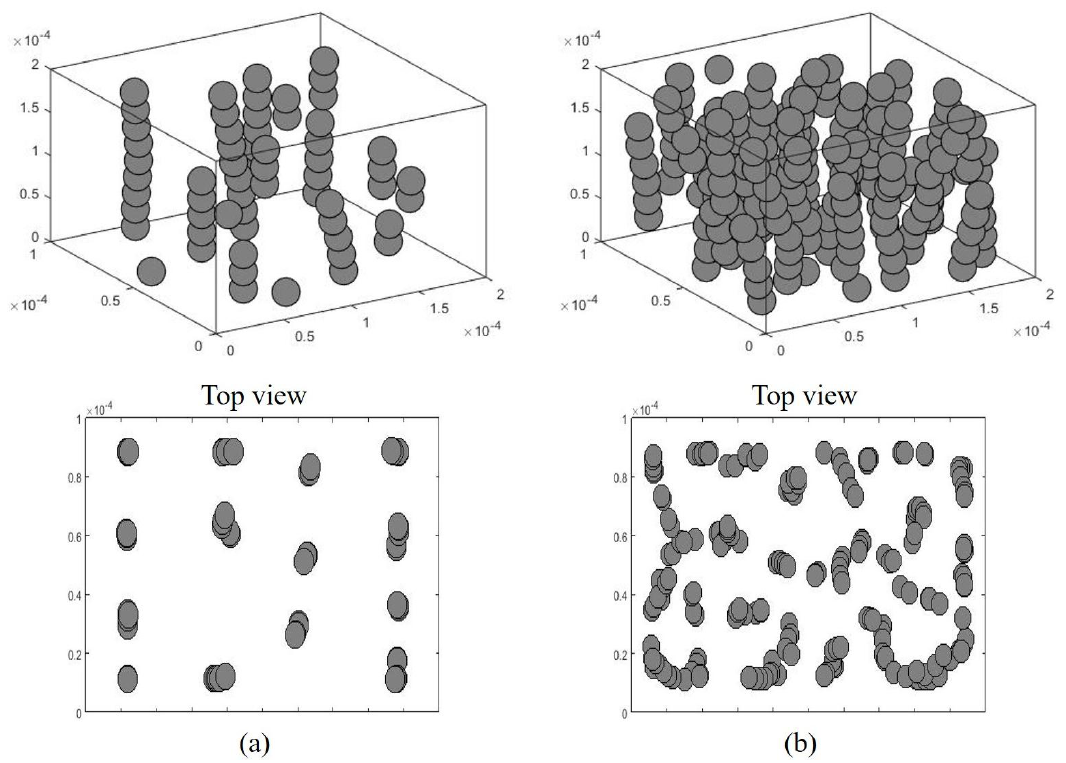
Figure 2. 3D simulation results of particle alignments in composite structures; ( a ) 5 vol.% nickel particles; and ( b ) 30 vol.% nickel particles.